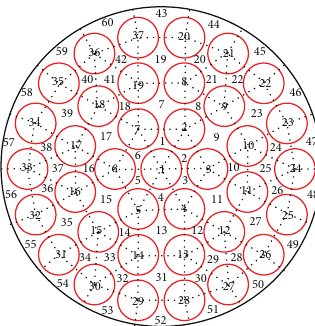
Figure 2: Rod and subchannel numbers of a 37S fuel bundle.